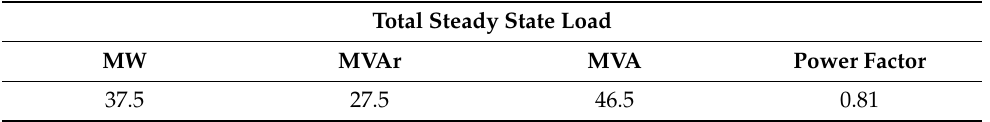
Table 3. Total active, reactive and apparent power required by SSED distribution subsystem of DTT. The total steady-state 20-kV load does not include the load of LC3 and LC4 (LV loads only) indicated above because they are accounted for in the total load of LC5 from which they are